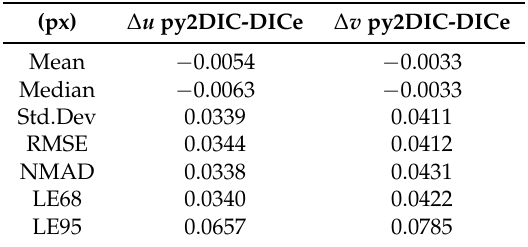
Table 5. Comparison with DICe : statistical parameters of displacement differences.